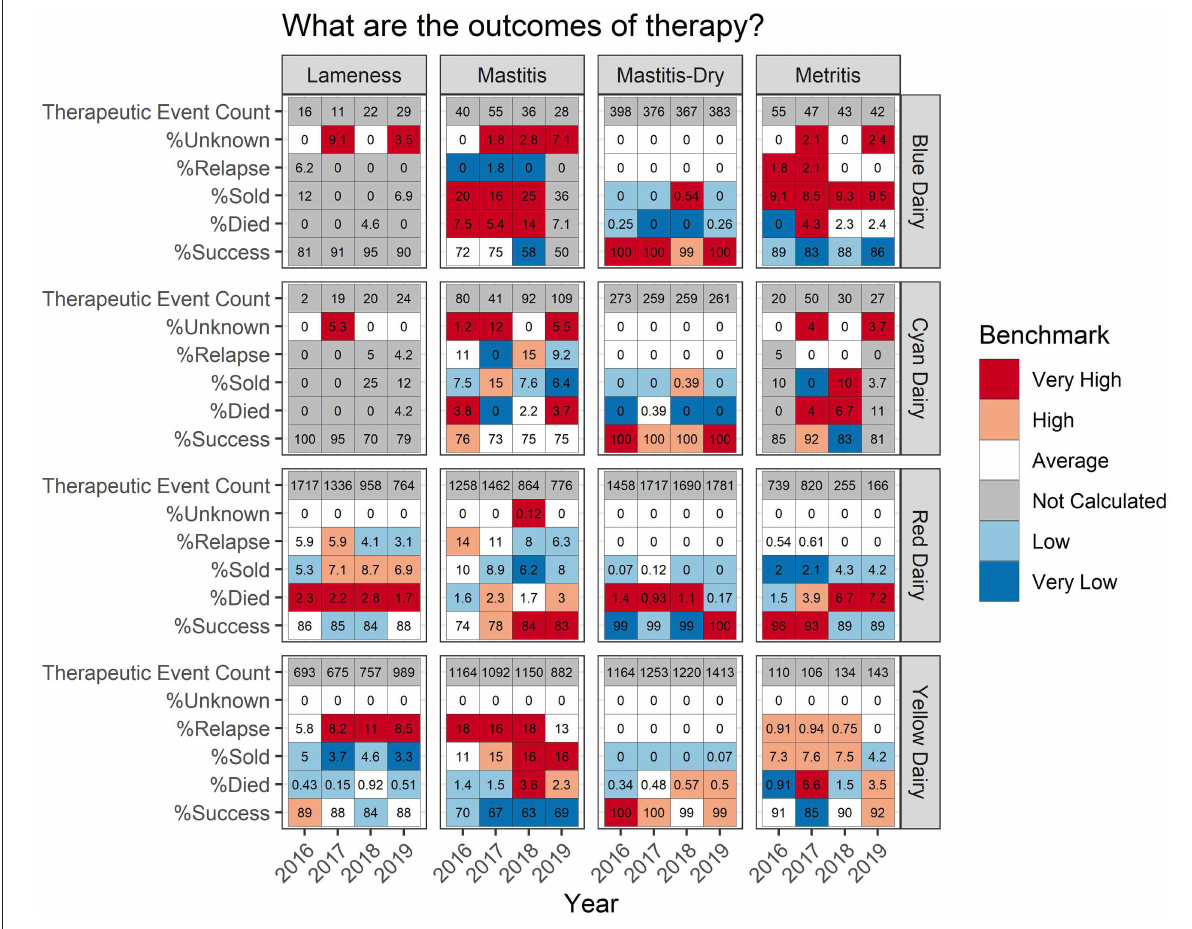
FIGURE5 For each measure listed on left the value is reported numerically within the cell. The background color indicates how that value ranks compared to other participating dairies. Occasionally outcomes could not be accurately determined due to/data quality issues associated with cow identity. This occurred more frequently for dairies with hand written treatment records i.e., Blue Dairy and Cyan Dairy.